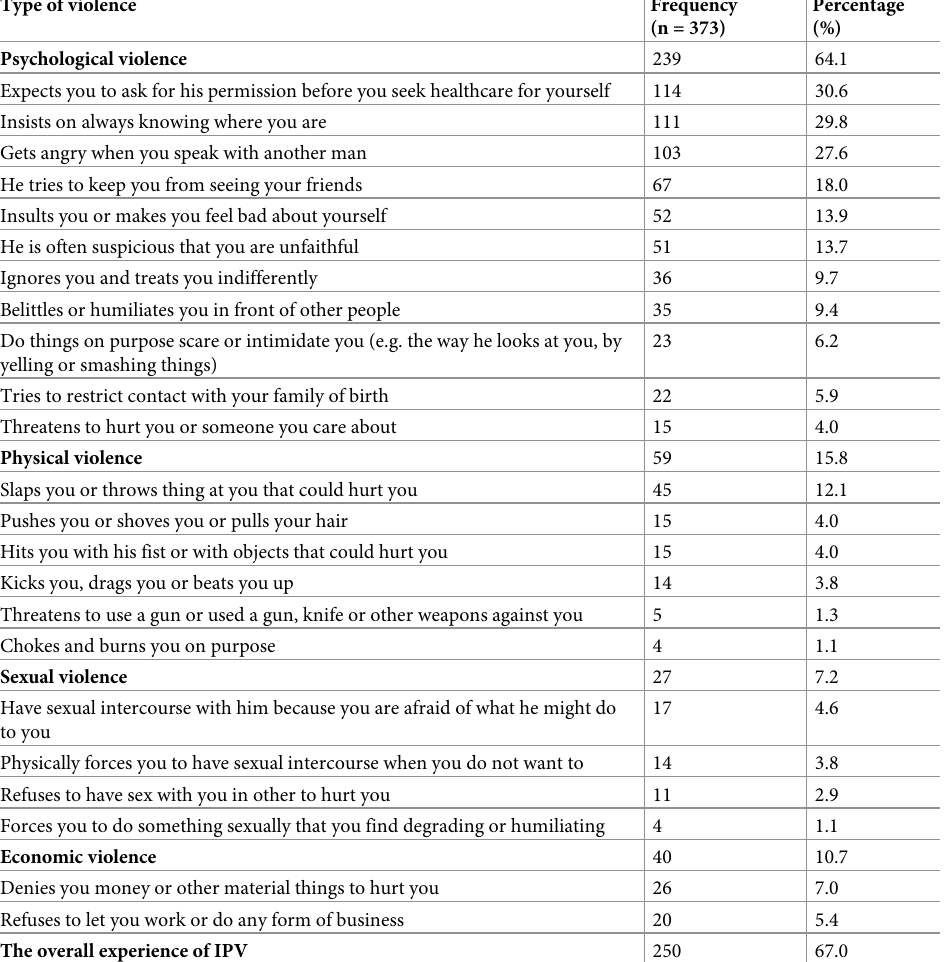
Table 4. Prevalence of intimate partner violence among pregnant women seeking antenatal services at public health care facilities in the rural Gambia,